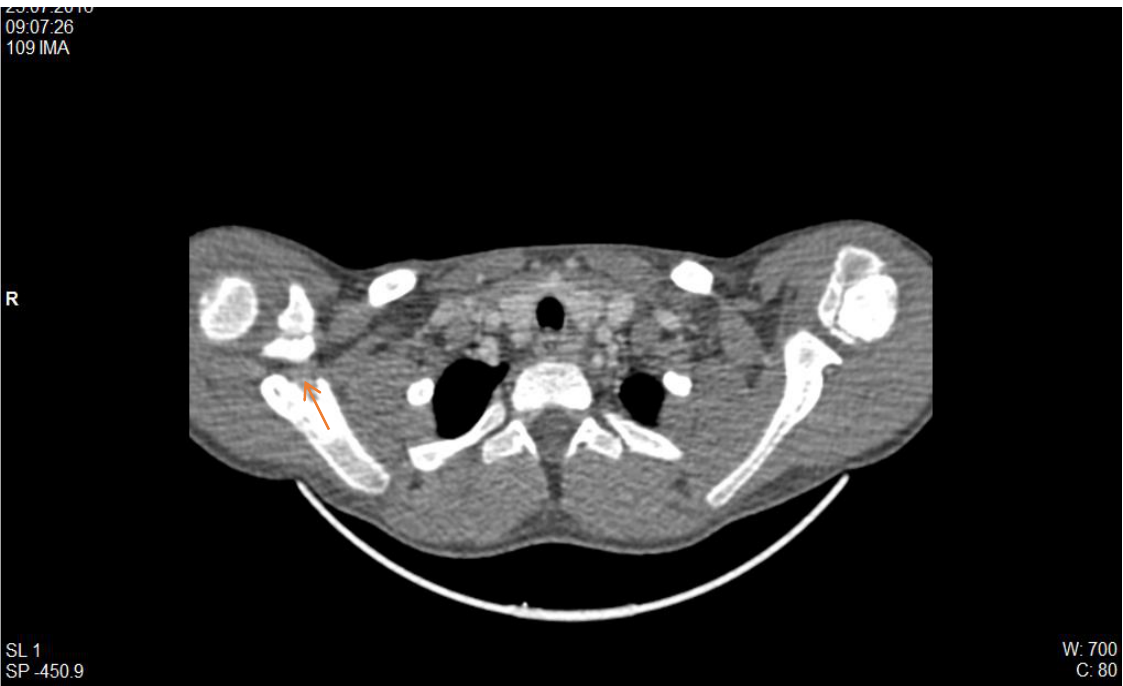
Figure 4. CT scan, right IJV thrombosis (red arrow) (personal collection Nephrology Department).